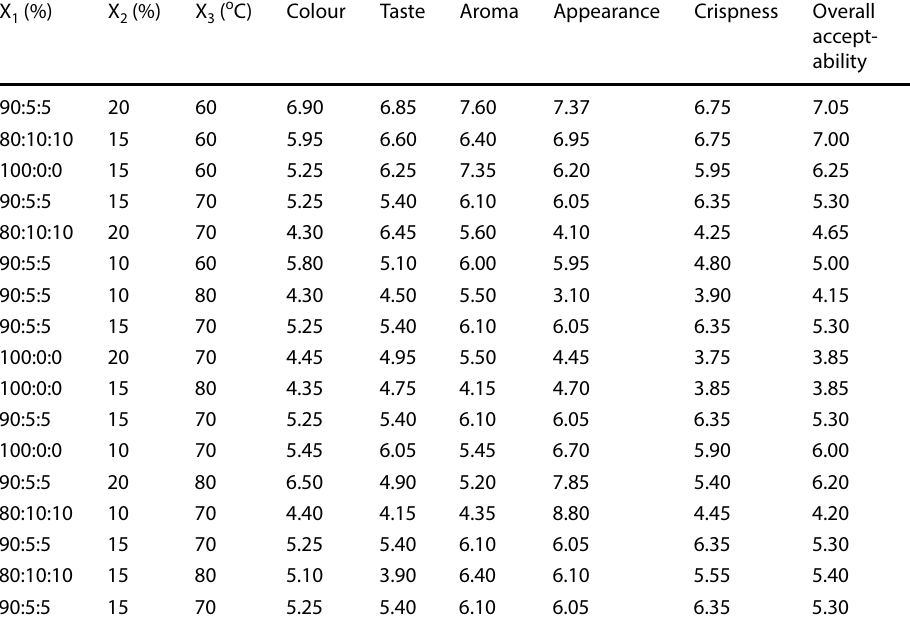
Table 6 Sensory properties of pearl millet-based extruded